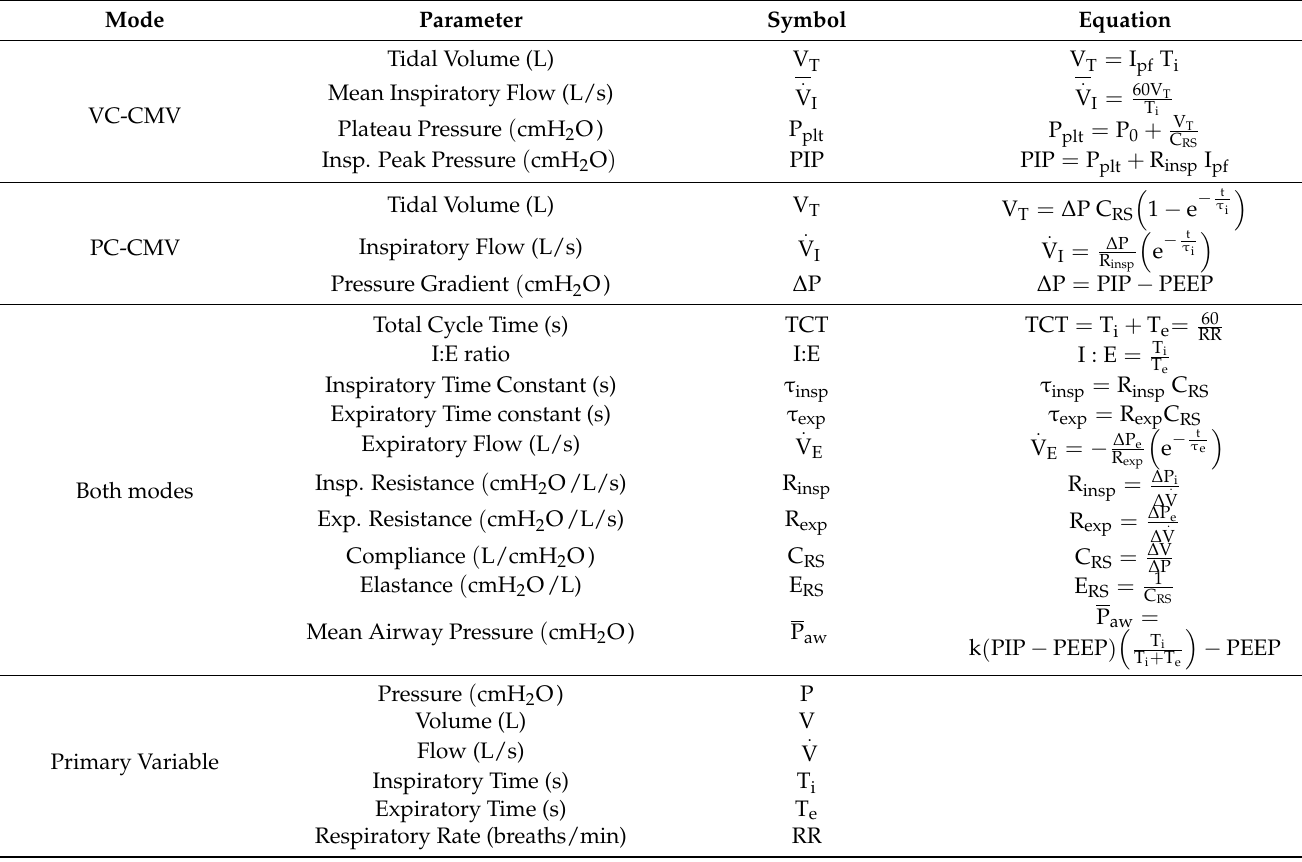
Table 3. Equations relating the important parameters for VC-CMV and PC-CMV mode, adapted from